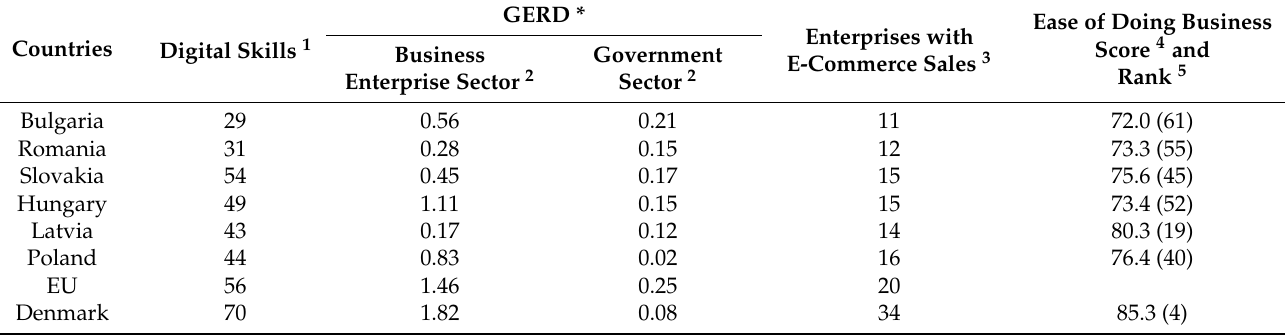
Table 8. Barriers to